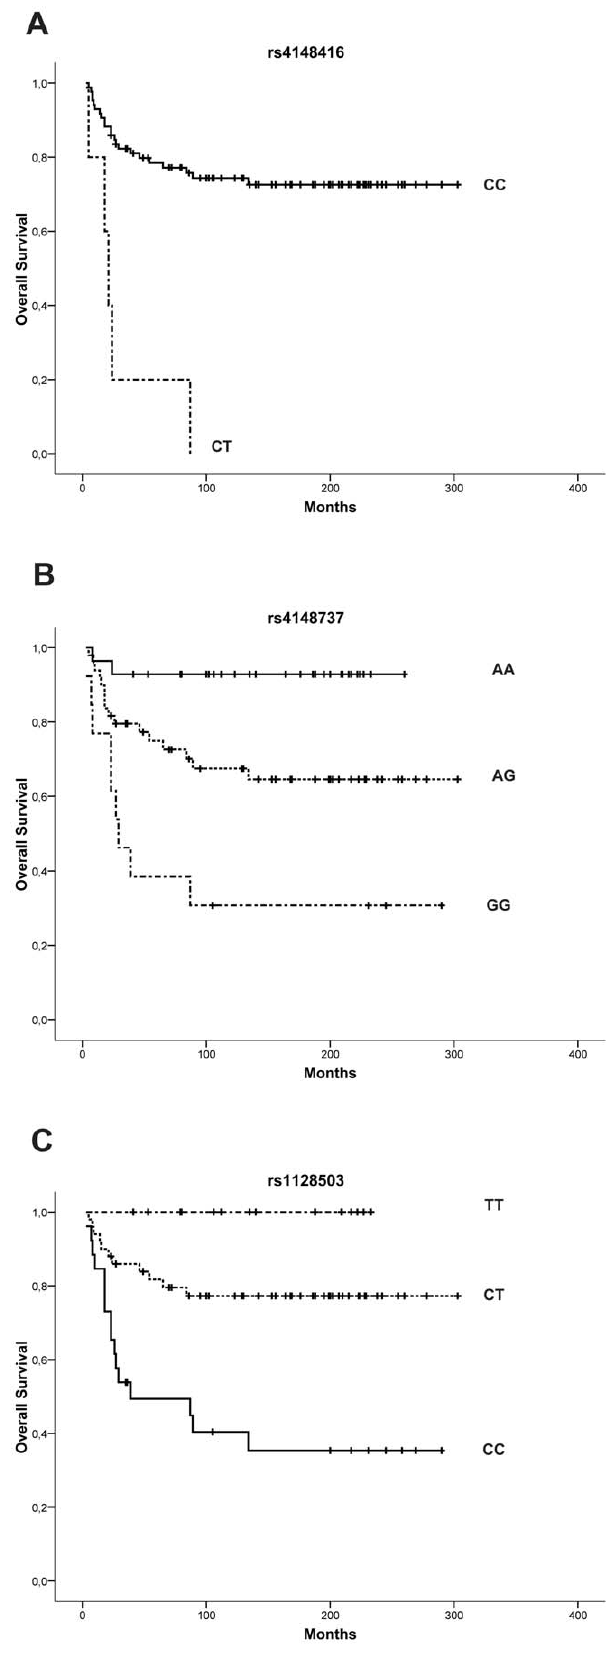
Figure 1. Kaplan-Meier survival curves for osteosarcoma patients according to genotype for (A) rs4148416 in ABCC3 (X 2 = 21.4, p-value = 3.8 6 10 2 6 ); (B) rs4148737 in ABCB1 (X 2 = 18.4, p-value = 1.0 6 10 2 4 ); and (C) rs1128503 or rs10276036 in ABCB1 (X 2 =20.9, p-value =2.9 6 10 2 5